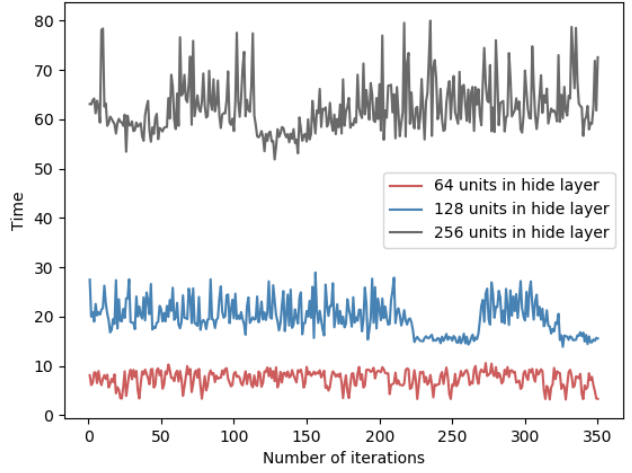
Figure 11. Per-iteration time spent on fatigue dataset for different sizes of hidden layers.